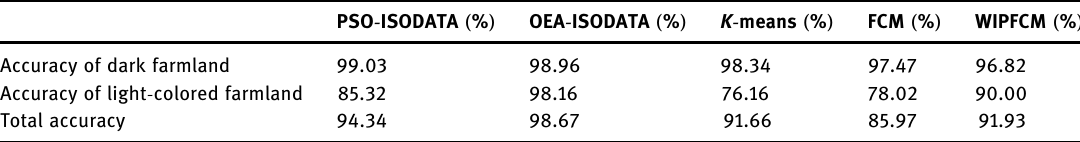
Table 2: Comparison of segmentation accuracy of di ff erent algorithms for farmland SAR image